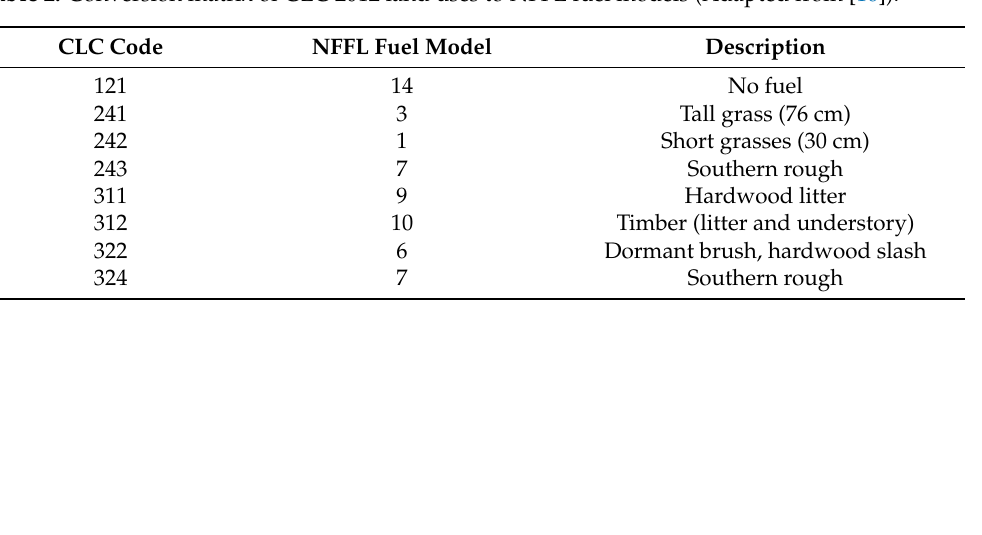
Table 2. Conversion matrix of CLC 2012 land uses to NFFL fuel models (Adapted from